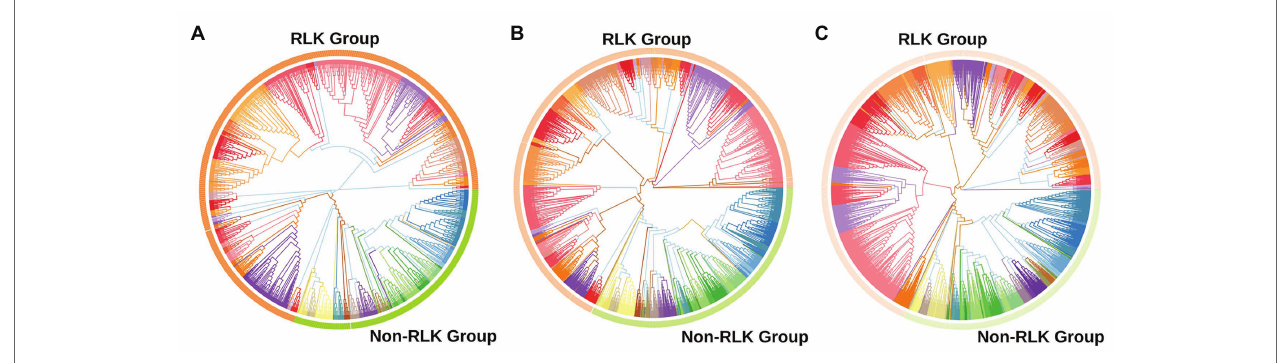
FIGURE 1 | Phylogenetic analyses of putative protein kinases (PKs) identified in the Saccharum spontaneum (Ssp) and Sorghum bicolor (Sbi) genomes. (A) Phylogenetic tree of the 1,210 Sbi PKs organized in 120 subfamilies represented by different colors. (B) Phylogenetic tree of the 2,919 Ssp PKs organized in 119 subfamilies. (C) Phylogenetic tree of PKs in both Sbi and